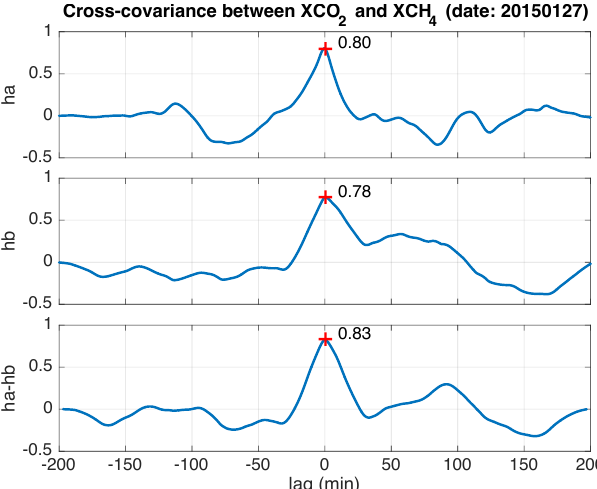
Figure F1. The whole day measurements on 15 January 2015 for ha, hb and pl. We neglect the wind measurements with wind speeds reported as zero. Gradient measurements between 1 and 2h after solar noon are selected (Fig. 4b) because of the relatively consistent wind speeds and directions at KONT and KCNO.